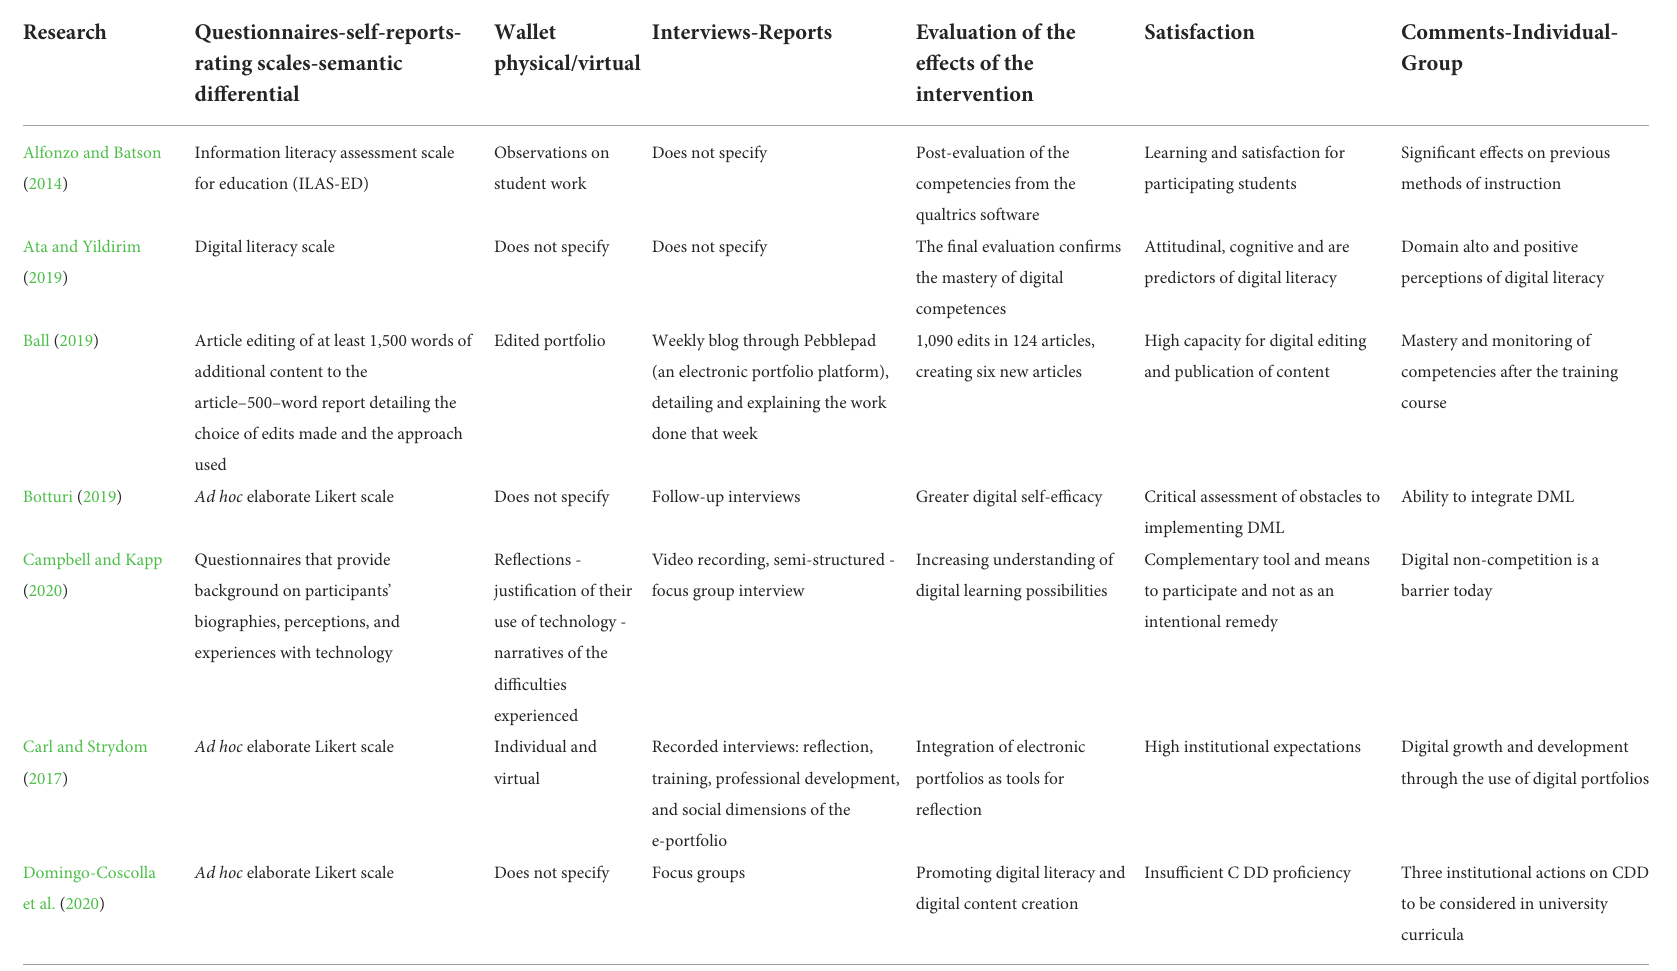
TABLE 4 Assessment instruments used in the instructional intervention in the reviewed